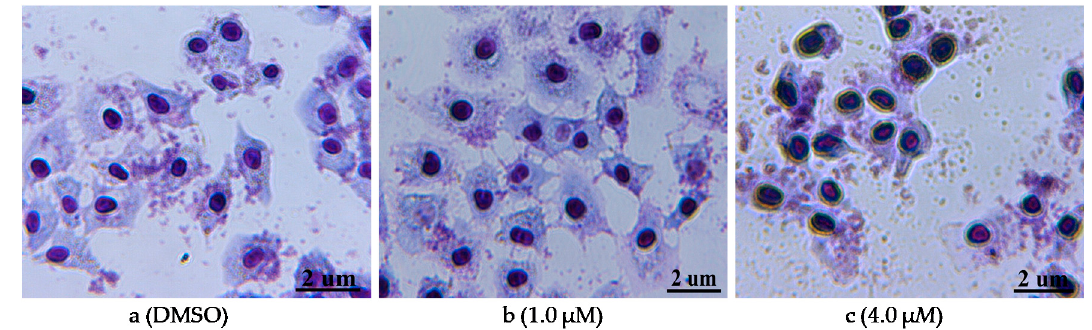
Figure 3. Morphological changes of PC-3 cells through Giemsa staining. ( a ) DMSO used as the negative control; ( b , c ) dealt with compound 12n for 48 h at the concentration of 1.0 and 4.0 μ M, respectively.